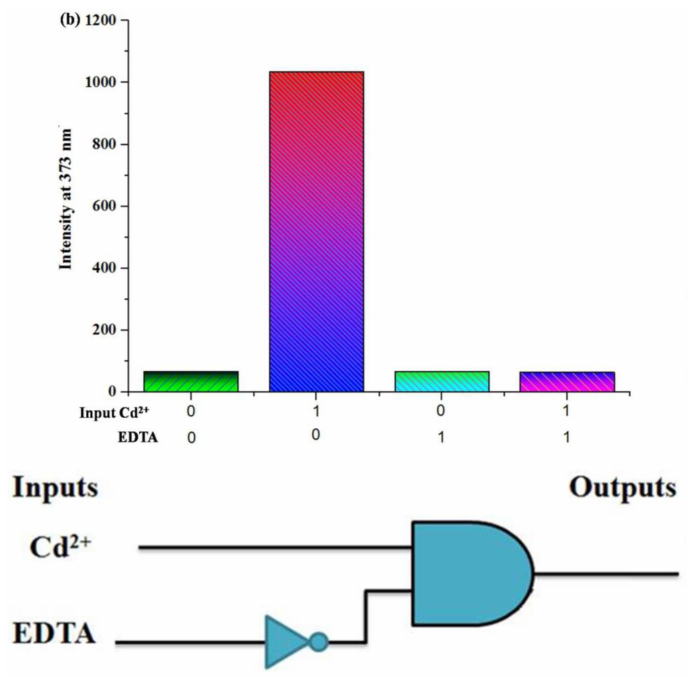
Figure 7. ( a ) Schematic presentation of “OFF–ON” system for sensor H 4 L (c = 1 × 10 − 5 M) in the existence of Cd 2+ (c = 1 × 10 − 3 M) and EDTA (c = 1 × 10 − 3 M); ( b ) Performance of sensor H 4 L in the INHIBIT gate mode in Tris-phosphate buffer (c = 0.2 M, DMF/H 2 O = 9:1, v / v , pH = 7.0, λ ex = 373 nm). The bars display the fluorescent output of sensor H 4 L at 373 nm in the existence of Cd 2+ and EDTA serve as inputs. Table 1. The molecular logic gate and the each symbolic expression of the INHIBIT logic gate function. Inputs Outputs Cd 2+ EDTA (INHIBIT Logic Gate) Intensity λ max 0 0 low flu. 0 1 0 high flu. 1 0 1 low flu. 0 1 1 low flu.